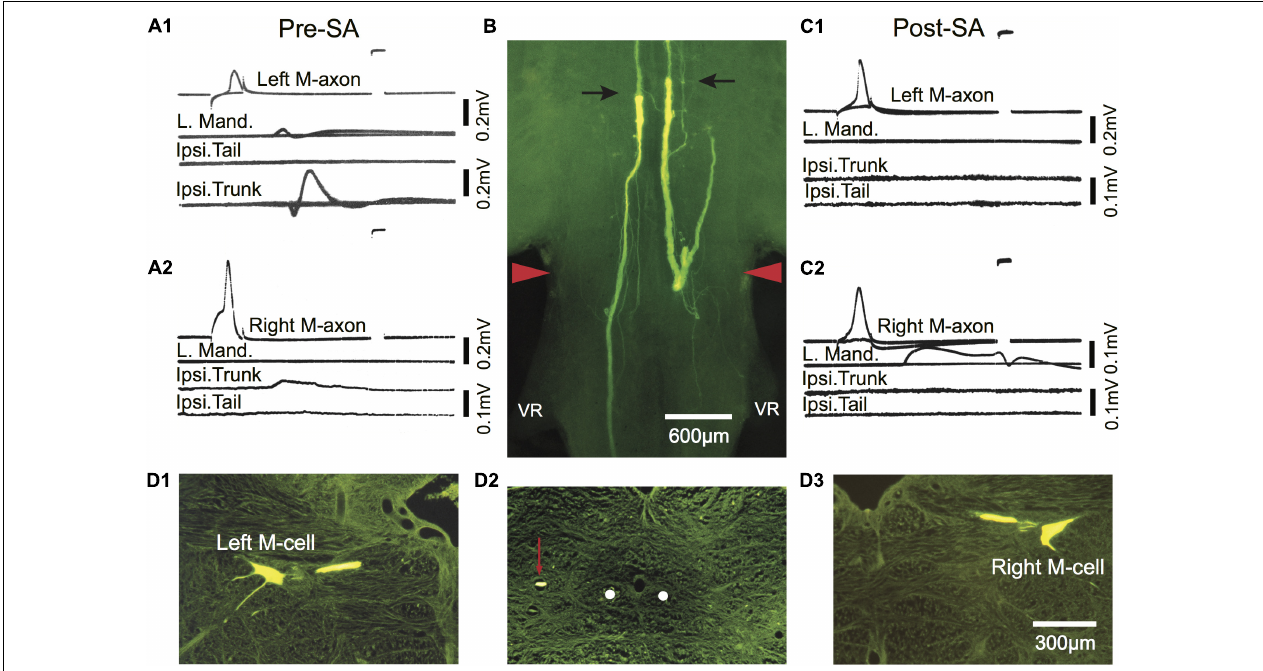
FIGURE 8 | Post-injury trunk EMG responses evoked by threshold stimulation of the M-axon are abolished after selective axotomy. (A1,A2) EMG recordings evoked by stimulation of the left (A1) and right (A2) M-axons 433 days postoperatively resulted in EMG responses in the trunk but not tail musculature. Note that the tail EMG is above the trunk EMG in panel (A1) . (B) Lucifer yellow-filled distal segments of selectively axotomized M-axons in a brain wholemount. The axons were axotomized after the recordings were made in panels (A1,A2) (Pre-SA). The top of the photograph shows the tips of the distal segments marked with arrows with only the sheath visible rostrally (i.e., above the arrows; proximal segment is not visible). The wound site is delineated by red arrowheads. (C1,C2) Stimulation of the proximal portion of the M-axon 13 days after selective axotomy (Post-SA). An M-axon spike in either axon did not elicit EMG responses in the trunk as it had pre-selective axotomy. (D1–D3) Cross sections (15 µ m) of the brain shown in the wholemount of panel (B) . (D1,D3) Left and right Mauthner cells filled by iontophoresis of Lucifer yellow into the proximal segments of the M-axons after selective axotomy. (D2) A cross section of the spinal cord just caudal to the first ventral root (VR), showing the position of the left axon sprout (red arrow) lateral and dorsal to the position the M-axons follow in control fish (white dots).